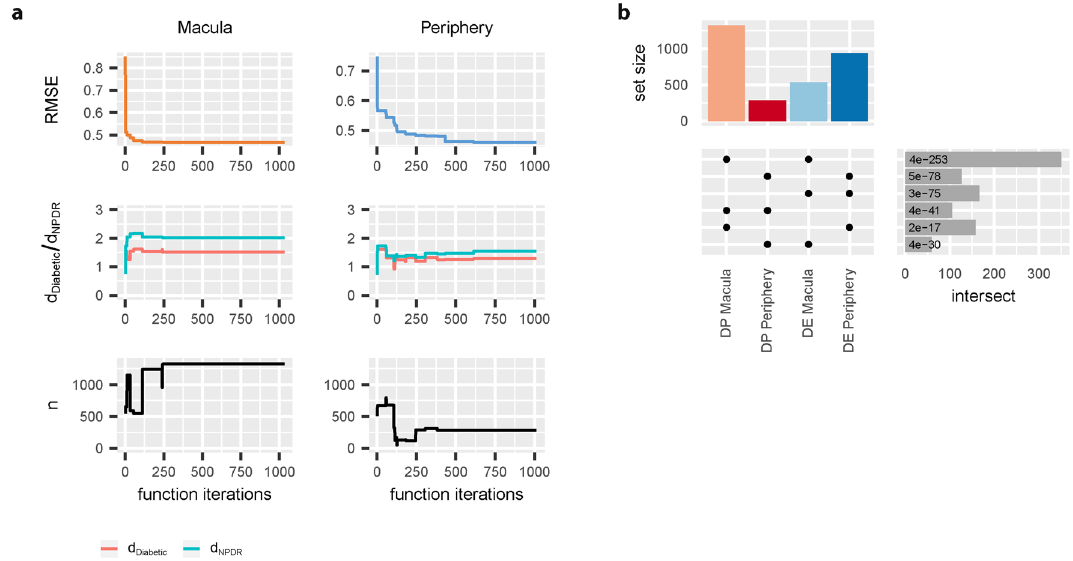
Figure 3. Identification of disease progression genes: ( a ) Convergence properties of sparse partial least squares regression model to identify disease progression (DP) transcripts: Minimum Root Mean Squared Prediction Error (RMSE) of the regression model after each function iteration for macula and periphery (upper panel). Value of d Diabetic and d NPDR model hyperparameters for the best model fit at each function iteration (middle panel) for macula and periphery samples. Number of selected transcripts (n) for the best model fit at each function iteration (lower panel). ( b ) Comparison of identified DP RNA with RNA identified from differential gene expression analysis (upper panel) and corresponding two-set intersects (lower right panel). Values in the lower right panel denote BH adjusted p values (hypergeometric